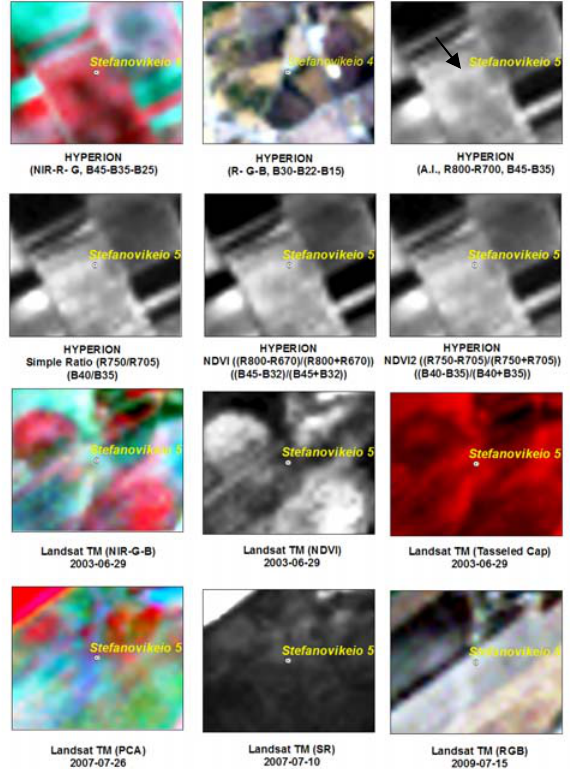
Figure 4. Application of different algorithms for the detection of crop marks in EO- Hyperion and Landsat data over the archaeological site of Stefanovikeio in Thessaly (Greece). The proposed archaeological index (1 st row, 3 rd column) was able to detect the crop mark.